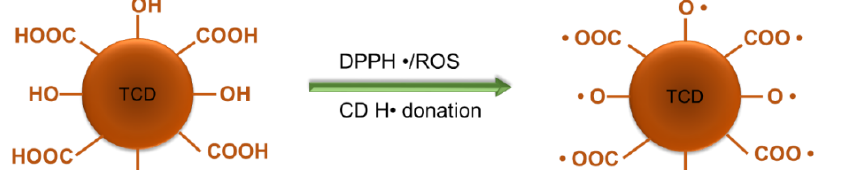
· /ROS reduction by antioxidant TCD in aqueous Figure 6. Mechanism of DPPH·/ROS reduction by antioxidant TCD in aqueous media. Figure 6. Mechanism of DPPH